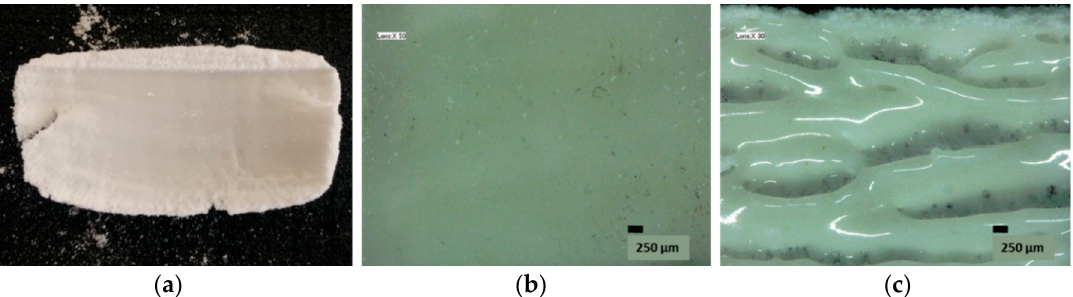
Figure 8. ( a ) Sintered rectangle on 80 µm final powder. Part caking is visible around the rectangle along with extensive warpage. The parts produced at these optimal parameter settings displayed a smooth morphology ( b ) whereas deviation from these parameters often results in nonconsolidated layers or severe necking or balling ( c ) [1,22].